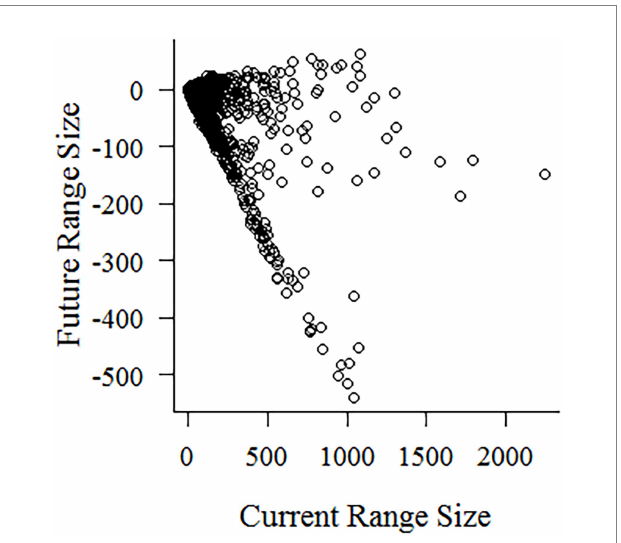
FIGURE 2 Changes in species’ range size in cell numbers, ranging from 540 losses to 63